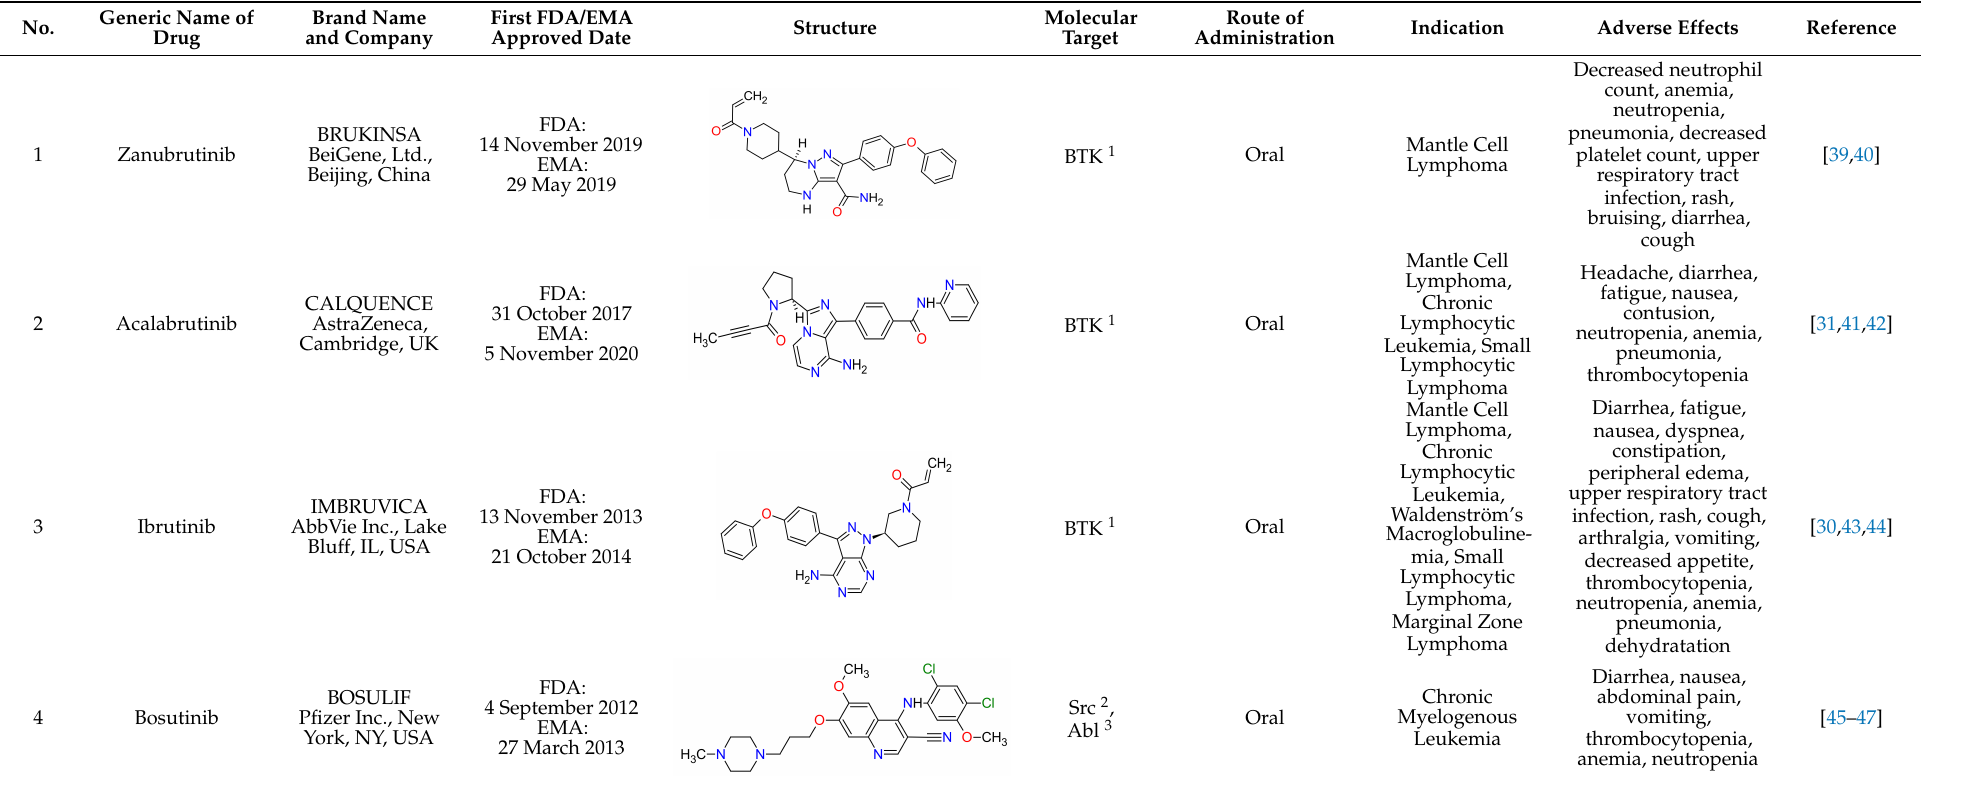
Table 1. Features of the tyrosine kinase (TK) inhibitors approved by the Food and Drug Administration (FDA) from 2011 to 2021. The order of drugs is tabulated in order of most recent to oldest registration